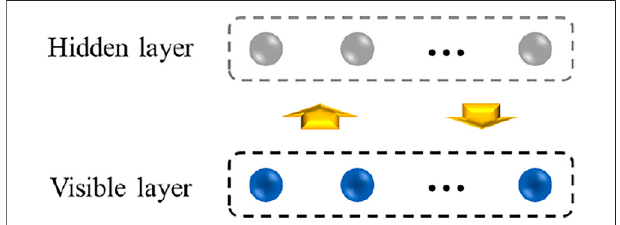
FIGURE 1 | The restricted Boltzmann